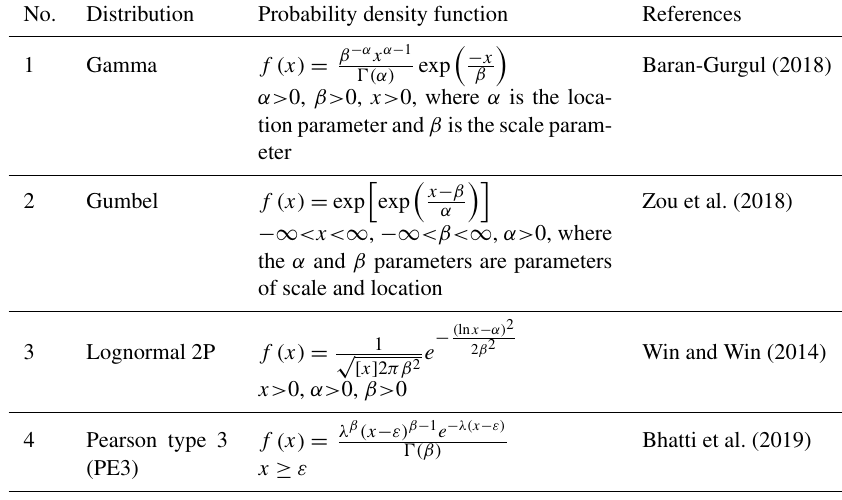
Table 2. Probability density function for gamma, Gumbel, lognormal 2P and Pearson type 3 distributions.